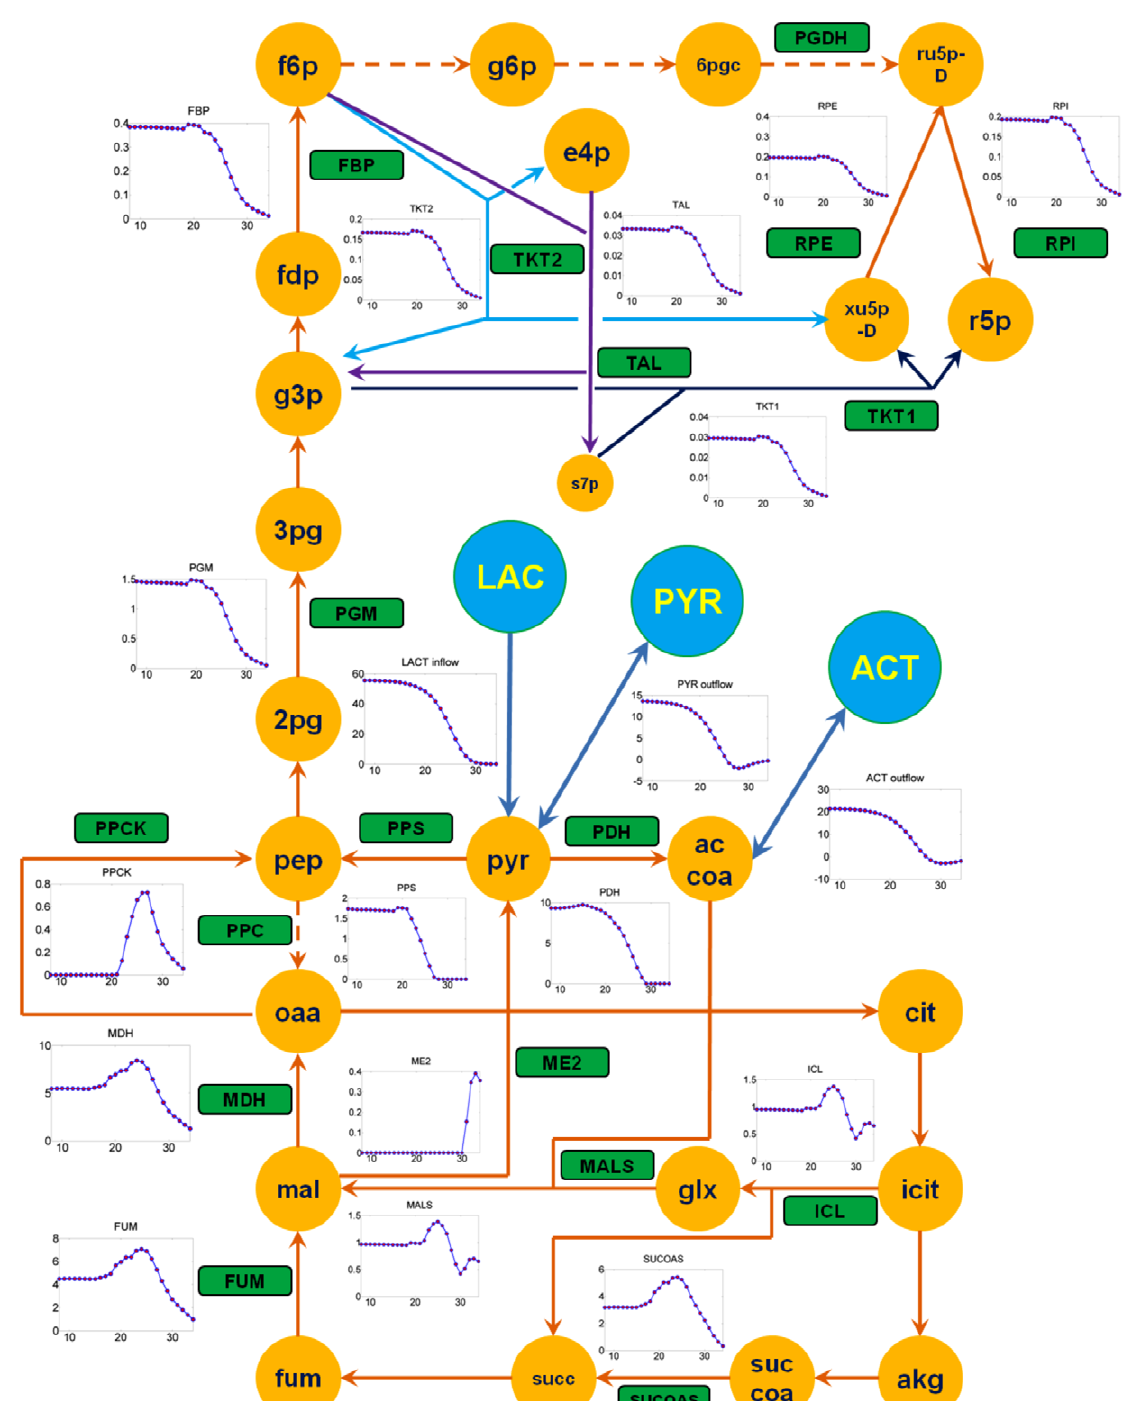
Figure 4. Dynamic flux distributions (unit: mmol/g DCW/h) in central metabolic pathways. The yellow filled cycles are intracellular metabolites; the blue filled cycles are substrates and extracellular metabolites (LAC: extracellular lactate, PYR: extracellular pyruvate, ACT: extracellular acetate); the dashed lines indicate inactive pathways; the green filled boxes are reactions listed in iSO783. All the abbreviations refer to iSO783 [7]. doi:10.1371/journal.pcbi.1002376.g004 (Ala, Ser, Glu, Asp, and Gly, at t = 24 and 30 h) are illustrated in fit still exists. One of the limitations of the FBA model is that the Figure 5A and Figure S1. Compared with the experimental intracellular pathway is treated as unidirectional, so the effect of measurements, the labeling patterns predicted by dFBA are exchange fluxes on isotopomer data is neglected. Considering consistent with the measured labeling patterns, but some lack-of- that some in vivo reactions could be bi-directional, we imple-